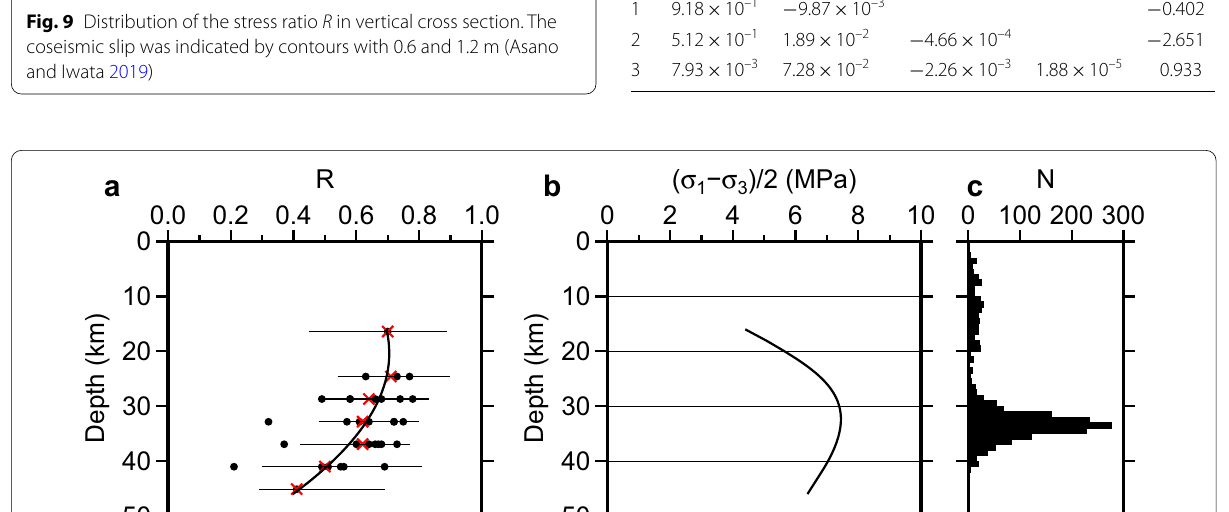
Fig. 10 Depth dependency of the stress ratio R . a Black dots are the R -value at each node and red crosses are the averaged values at each depth. Horizontal thin lines indicate the estimation error. A curved line is the best fitted line to the red crosses. b The maximum shear stress τ max ( σ 1 σ 3 )/2 as a function of depth. c Histogram of the depth of aftershocks shown in Fig. 3 = −